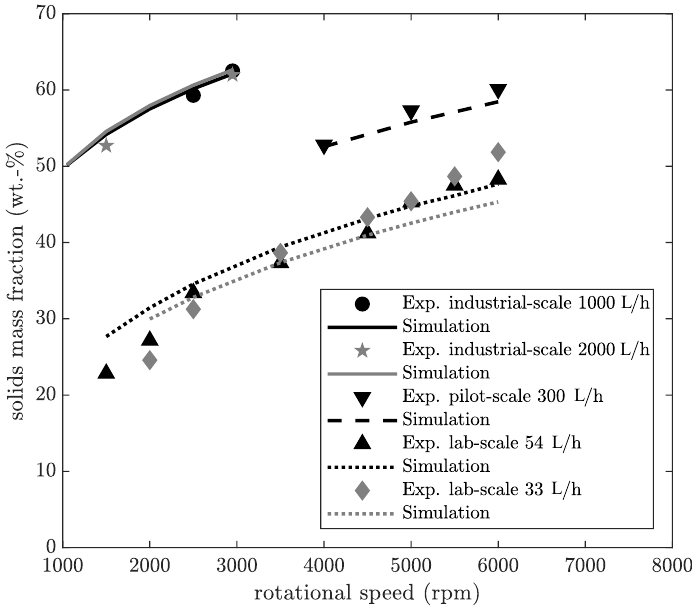
Figure 8. Solids mass fraction of the cake for three decanter centrifuge scales, volumetric flow rates, and rotational speeds: Comparison of simulation and experiment for CC2.